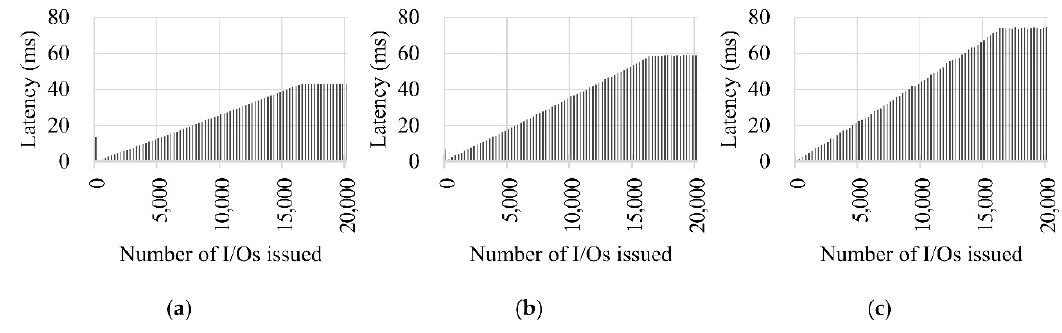
Figure 2. Latency of an I/O request when each SSD is busy. ( a ) SSD-A; ( b ) SSD-B; ( c ) SSD-C.